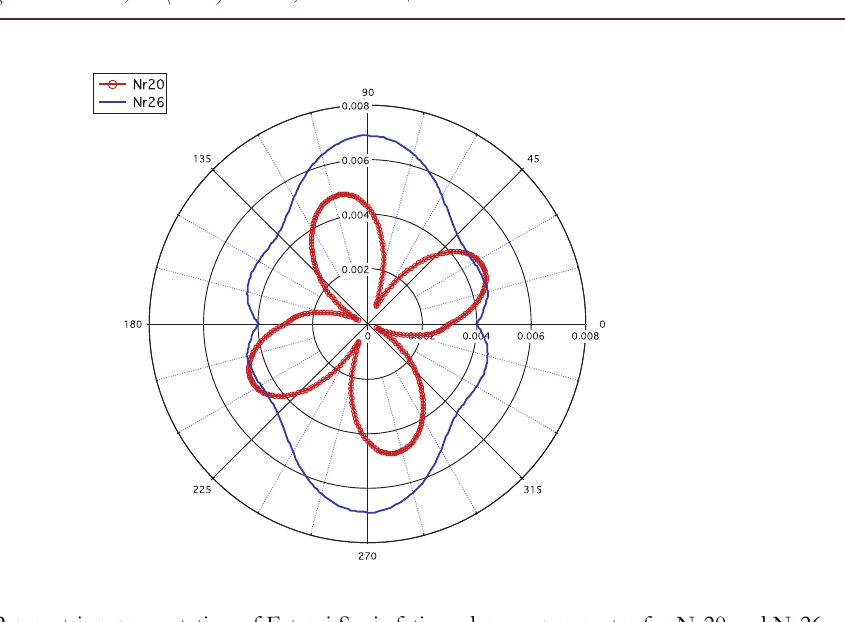
Figure 3: Parametric representation of Fatemi-Socie fatigue damage parameter for Nr20 and Nr26.